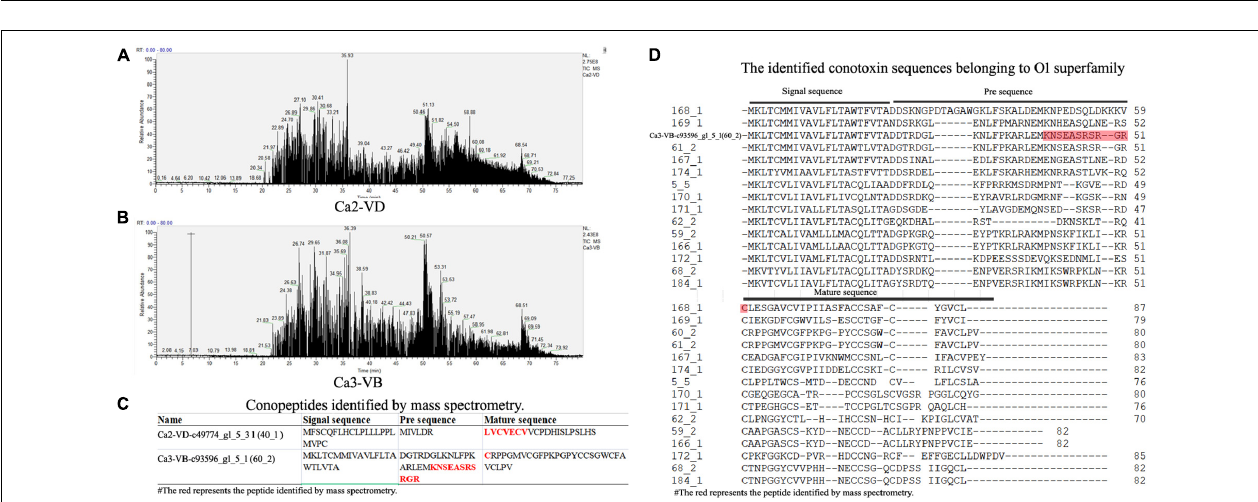
FIGURE 2 | The annotated predicted conopeptides. (A) , Relationships of the annotated candidate conopeptides between VD and VB in each individual, as predicted by ConoSorter. (B) , Relationships of the annotated candidate conopeptides between VD and VB in the three individuals, as predicted by ConoSorter. (C) , The identified candidate conopeptide precursors previously reported in C onus caracteristicus .